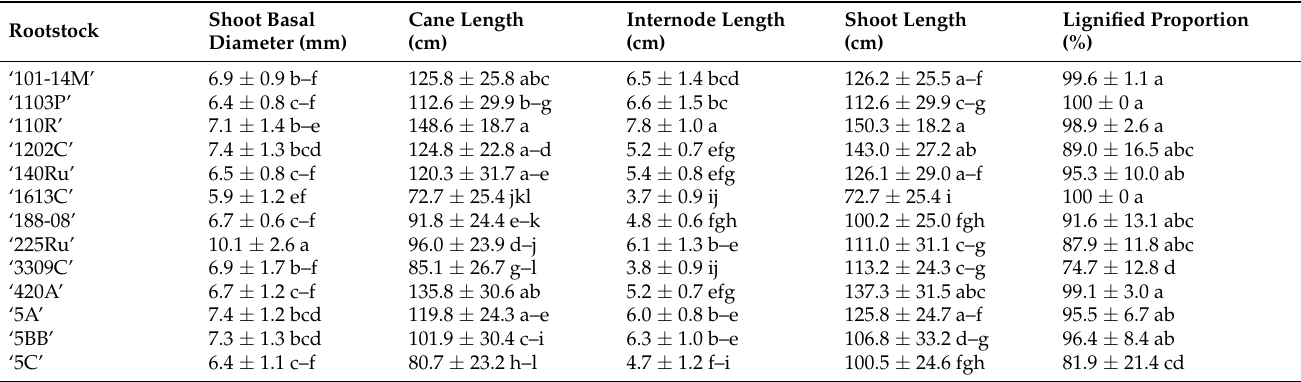
Table 3. Growth indicators of the shoot 90 days after planting the grapevine rootstock cuttings in the field (the young